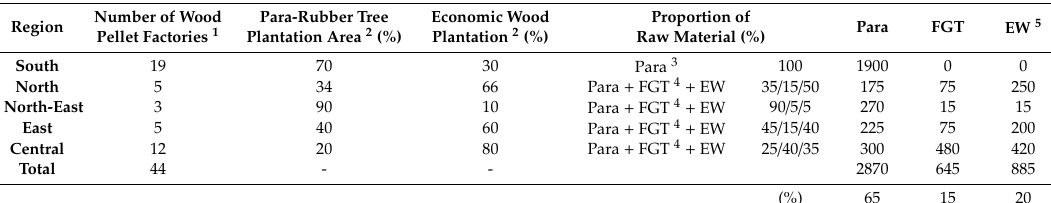
Table 5. Estimating the proportion of feedstock by type.